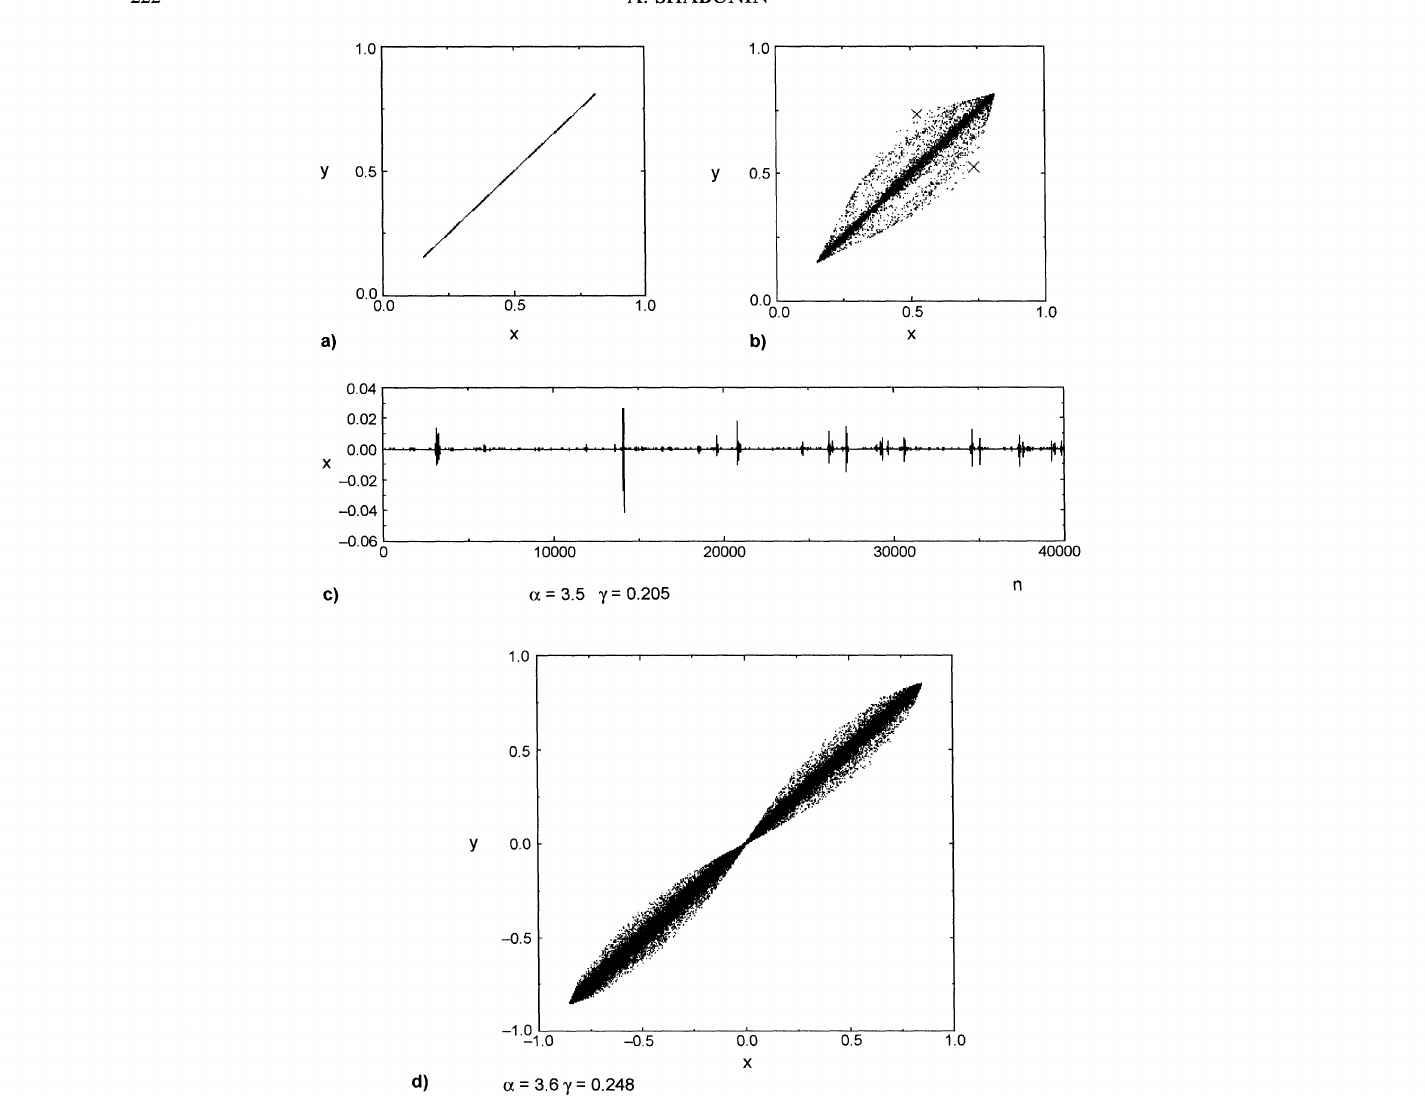
FIGURE 3 The phase portrait of the in-phase oscillations without noise (a) and with noise (b); time-series x,,- Yn of the bubbling attractor (c). The phase portrait of the bubbling united chaotic attractor